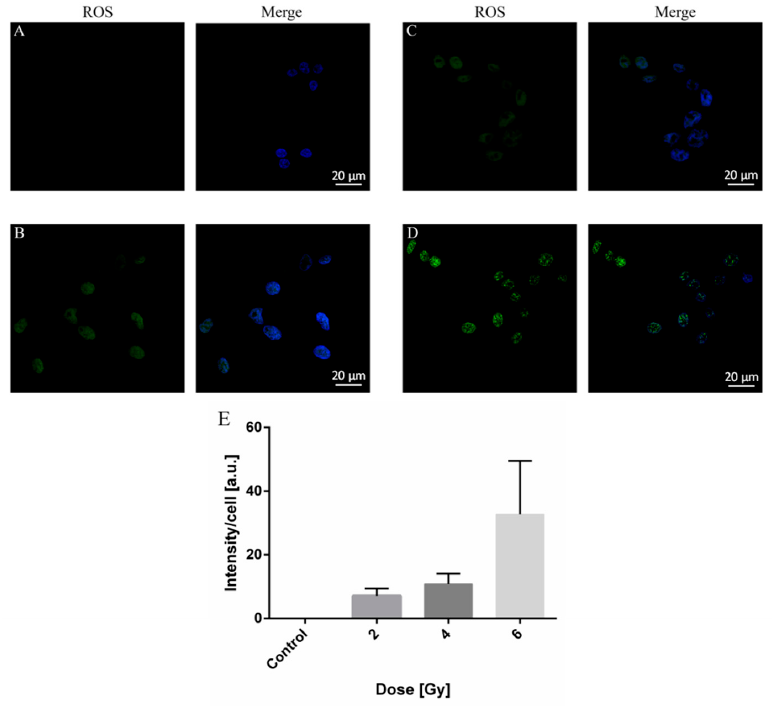
Figure 3. ROS generation in A375 cells induced by X-ray radiation: ( A ) not-exposed vs. exposed cells to ( B ) 2 Gy, ( C ) 4 Gy and ( D ) 6 Gy. ( E ) Quantification of ROS production from A–D by ImageJ.